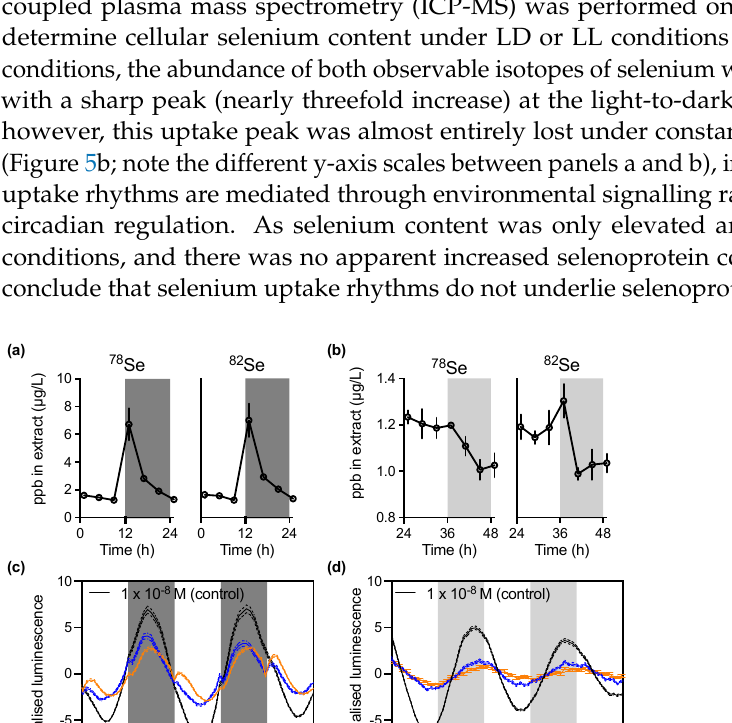
Figure 4. No correlation between protein and transcript peak abundance phase: ( a ) One-for-one phase relationship between rhythmic selenoproteins and their cognate transcripts, expressed as the peak abundance phase of the transcript minus the peak abundance phase of the protein. Values that correspond to a protein that peaks in a 2–6 h window after its transcript would map to the shaded area. ( b ) Protein versus mean transcript abundance across the LD cycle for ostta12g02030.